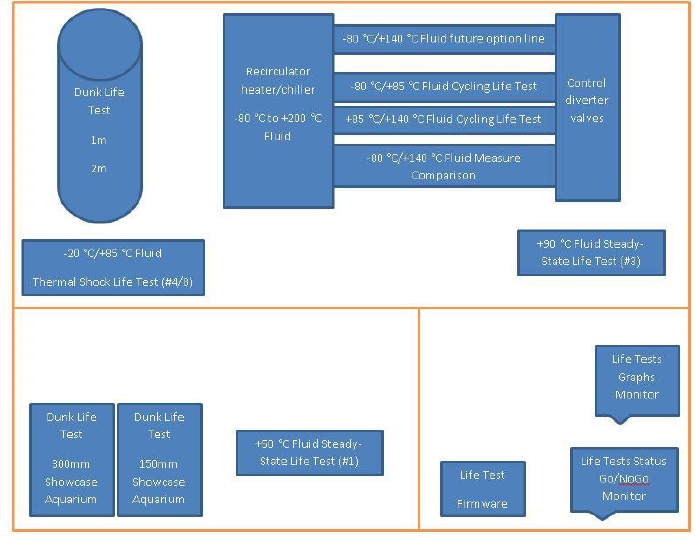
Figure 5. Life Test Stands in three adjoining rooms.